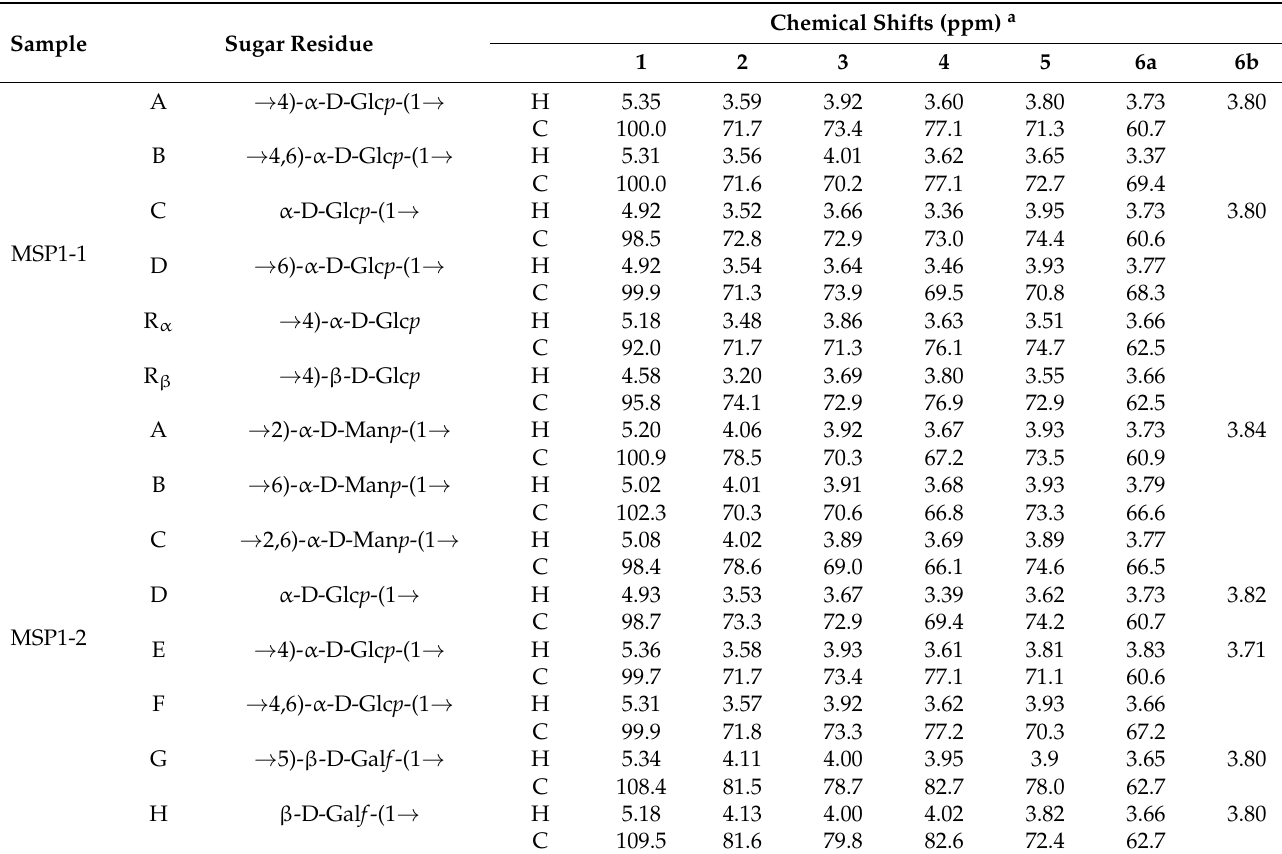
Table 2. 1 H and 13 C NMR chemical shifts for MSP1-1 and MSP1-2 in D 2